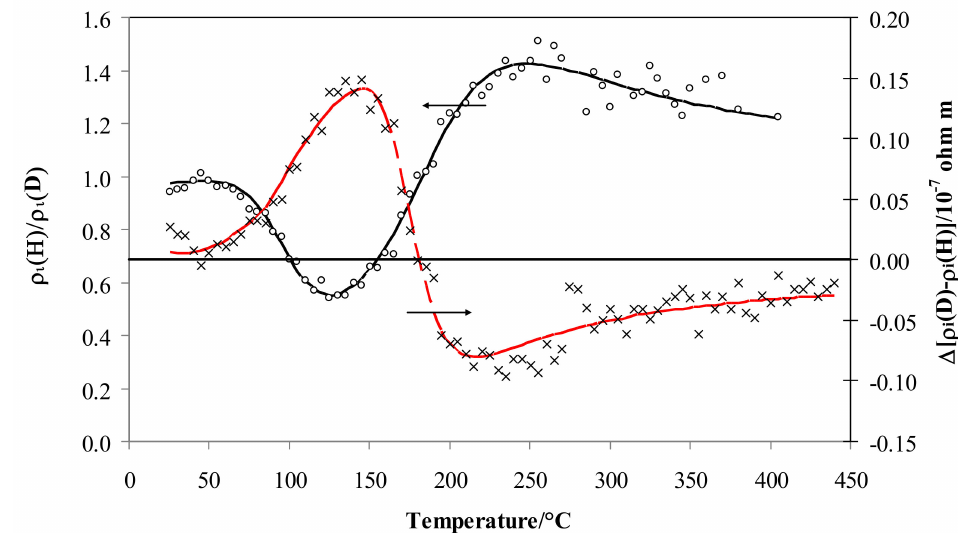
Figure 5. Ratio of ρ i vs. temperature for Pd-Ag 21 wt.% in pure hydrogen and deuterium (black) and the di ff erence in deuterium less hydrogen